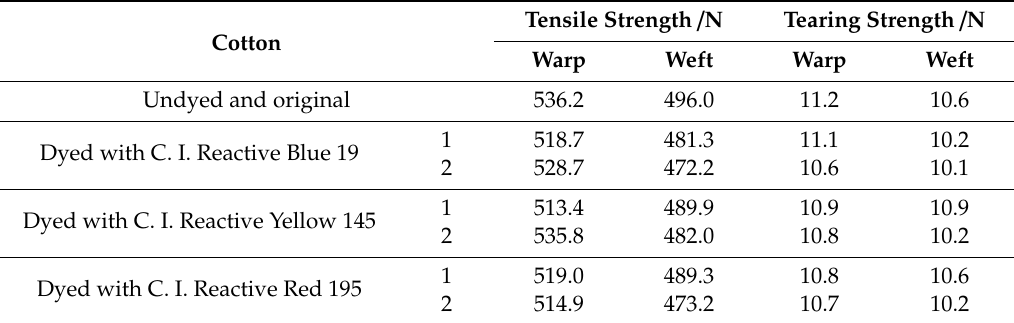
Table 4. Mechanical strength of the original and modified cotton dyed with reactive dyes Tensile Strength / N Tearing Strength / N Cotton Warp Weft Warp